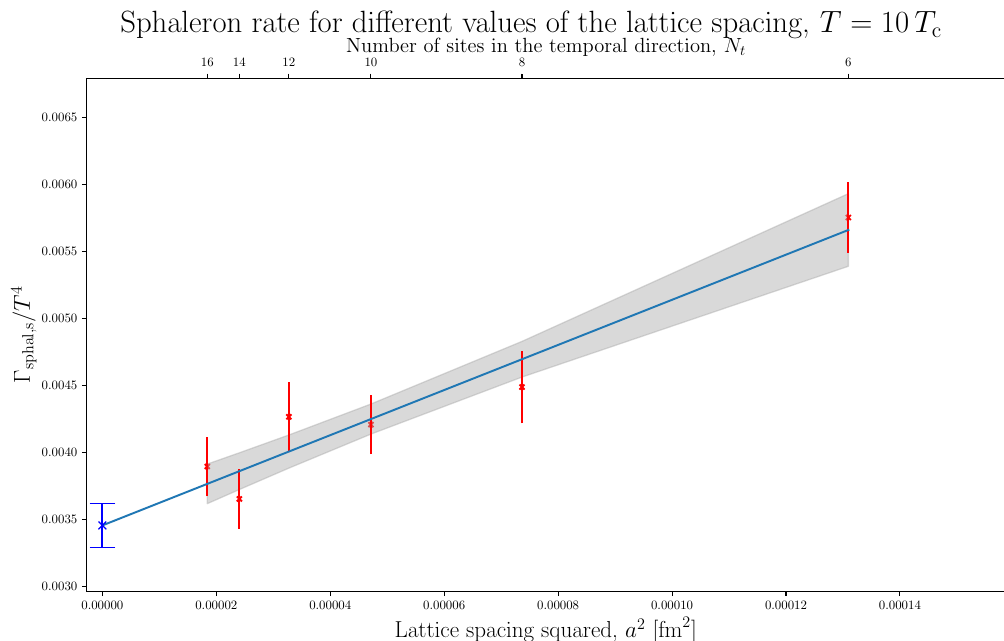
Figure 12 . Sphaleron rate calculated at the peak of each volume-dependence curve, extrapolated to zero gradient-flow-depth, at different values of lattice spacing a , for T = 10 T c . The zero-spacing extrapolation yields a value of Γ sphal ,s /T 4 = 0 . 0035 ± 0 . 0002